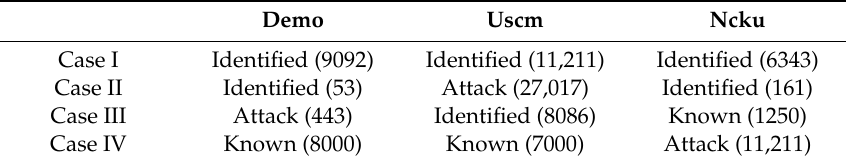
Table 1. Verification cases of network packets flow classification for three different tenants.